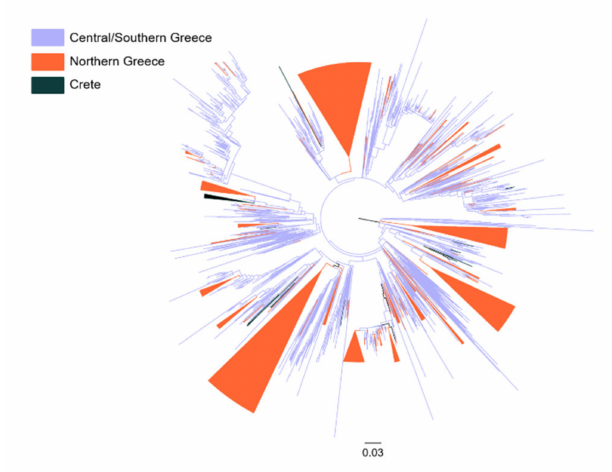
Figure 3. Unrooted phylogenetic tree estimated by RAxML v8.2.10 of HIV-1 subtype A1 sequences from Greece that fell within the large single molecular transmission cluster (MTC). Sequences from Central / Southern Greece are marked in light blue, sequences from Northern Greece in orange, and sequences from Crete in dark green. Clusters consisting of sequences from Northern Greece and Crete are indicated as triangles.